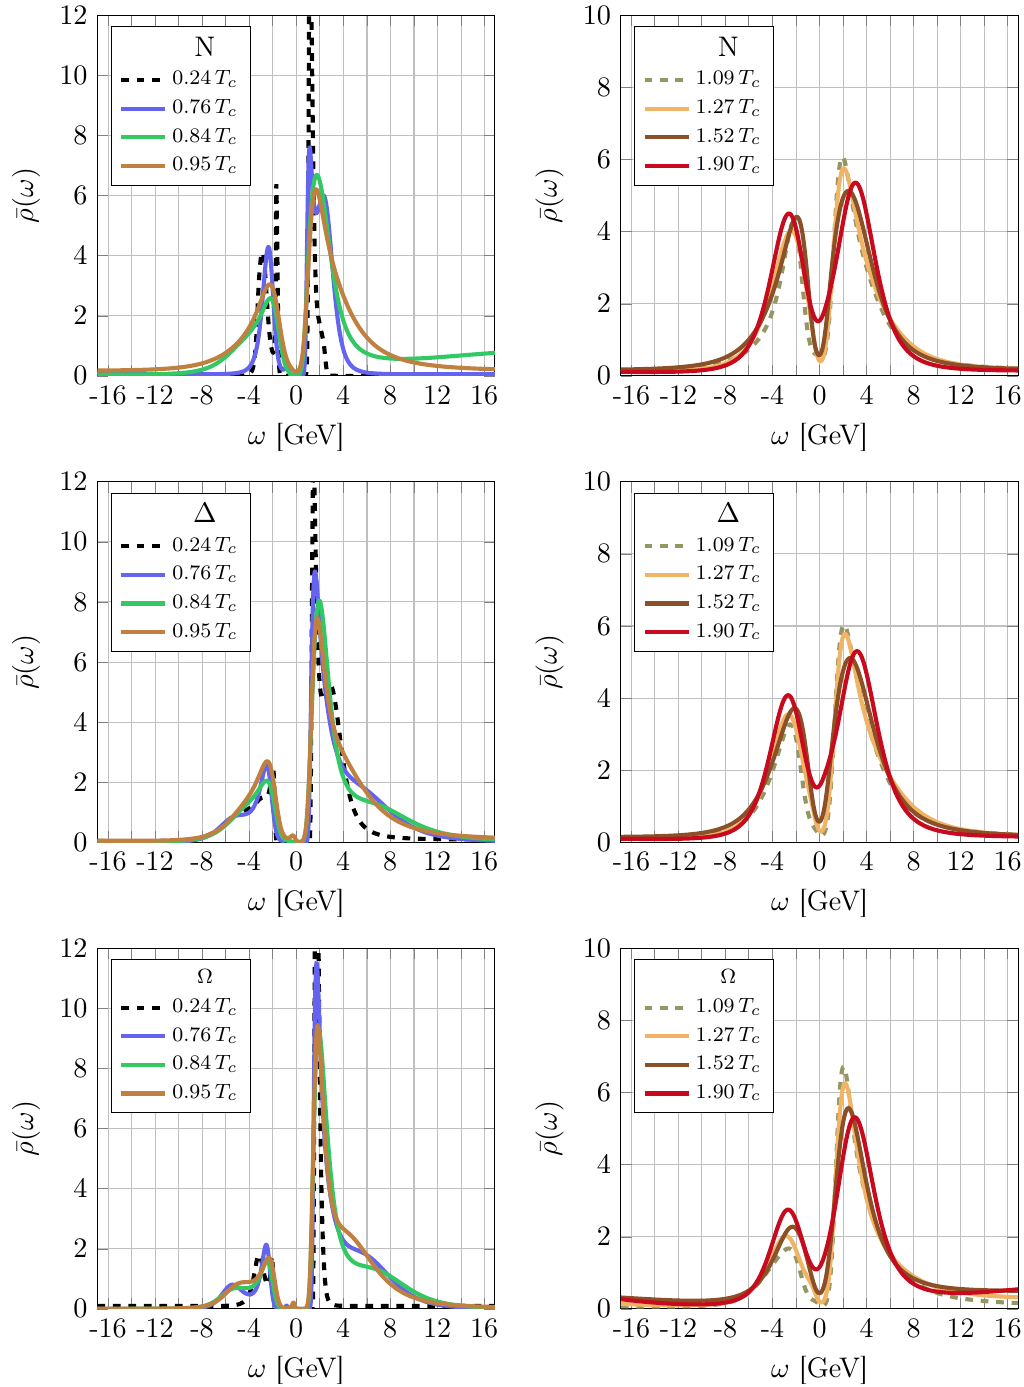
Figure 7 . Spectral functions below (left) and above (right) T c in the N (top), (cid:1) (centre) and (cid:10) (bottom)